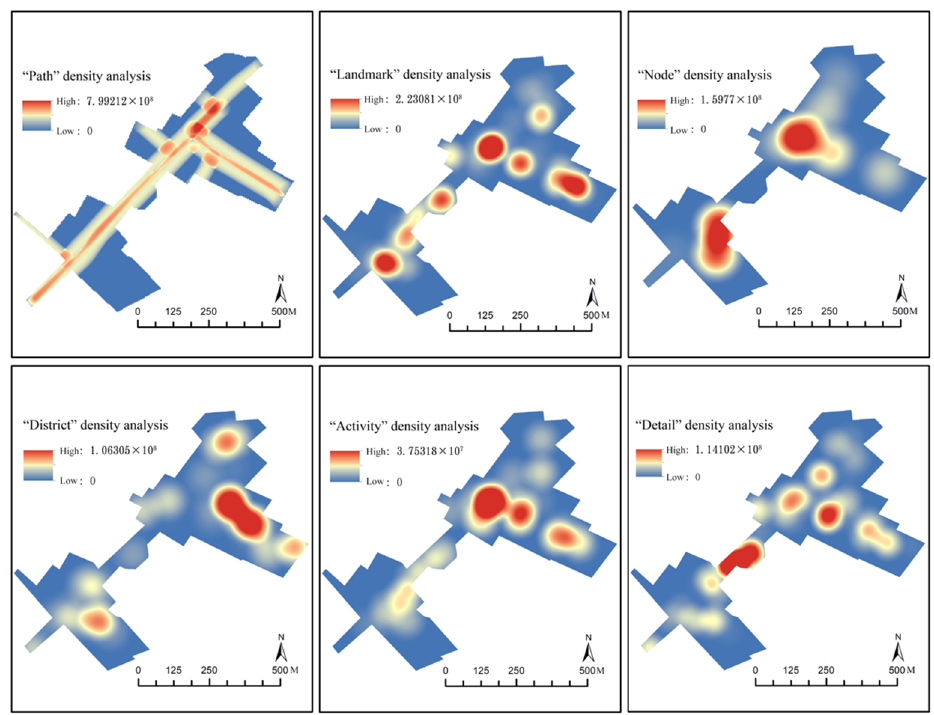
Figure 12. The Kernel density analysis of the distribution of categorized space in travel photos (source: authors).